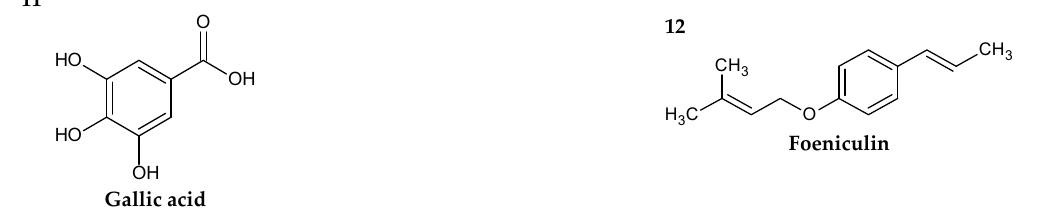
Figure 1. Chemical constituents of the leaves the C. americana L .